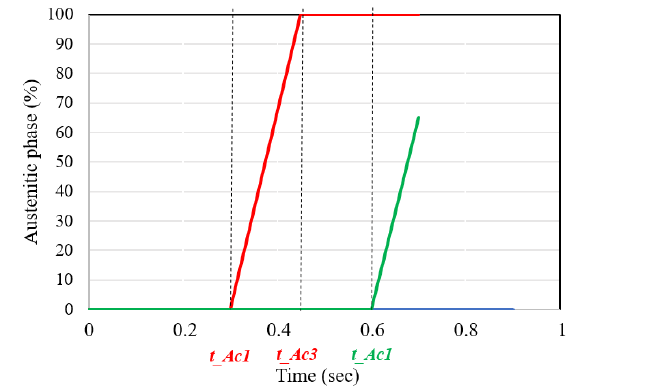
Figure 6. Three possible states of austenite phase